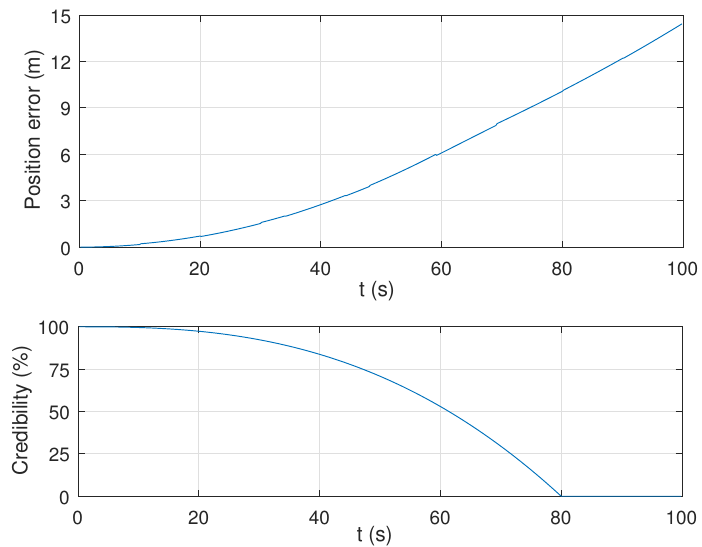
Figure 3. Position error of SINS and credibility evaluation result of